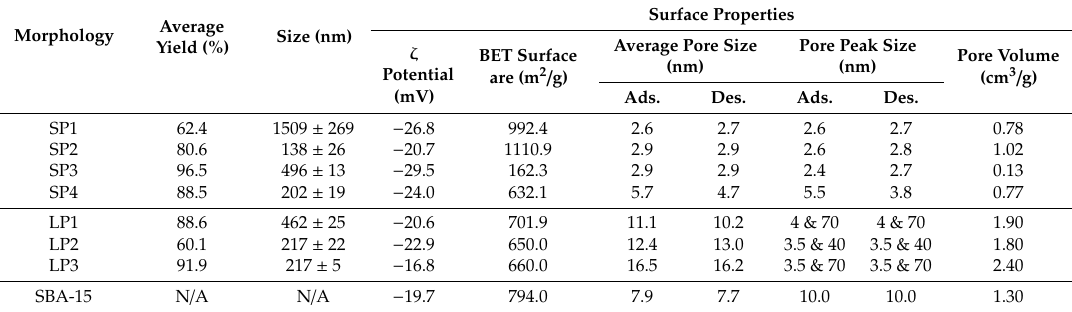
Table 2. Summary of nanoparticle properties. Size is shown as the average hydrodynamic diameter of the particles ± standard deviation. Zeta potential, surface area and calculated pore sizes and pore volumes are also shown. N / A = not